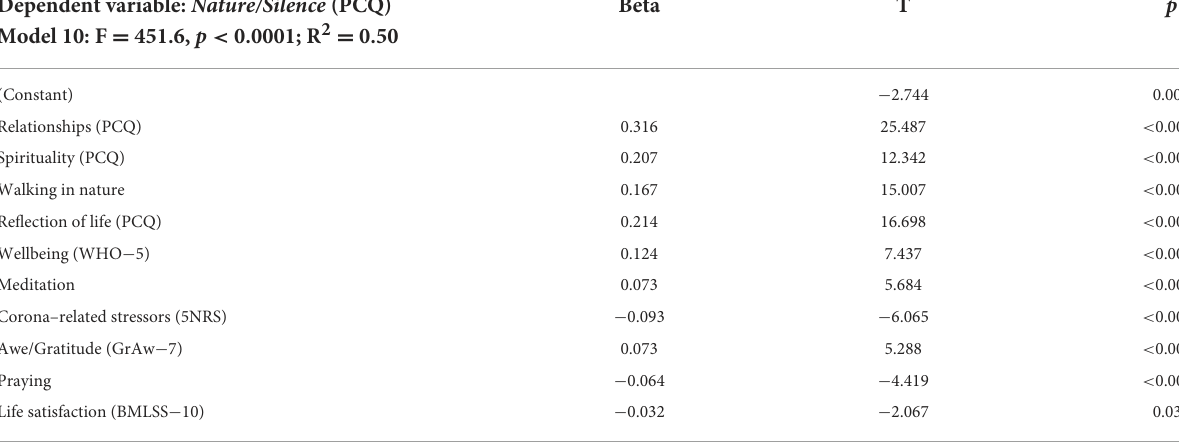
TABLE 5 Predictors of Nature/Silence as a dependent variable (stepwise regression analyses).